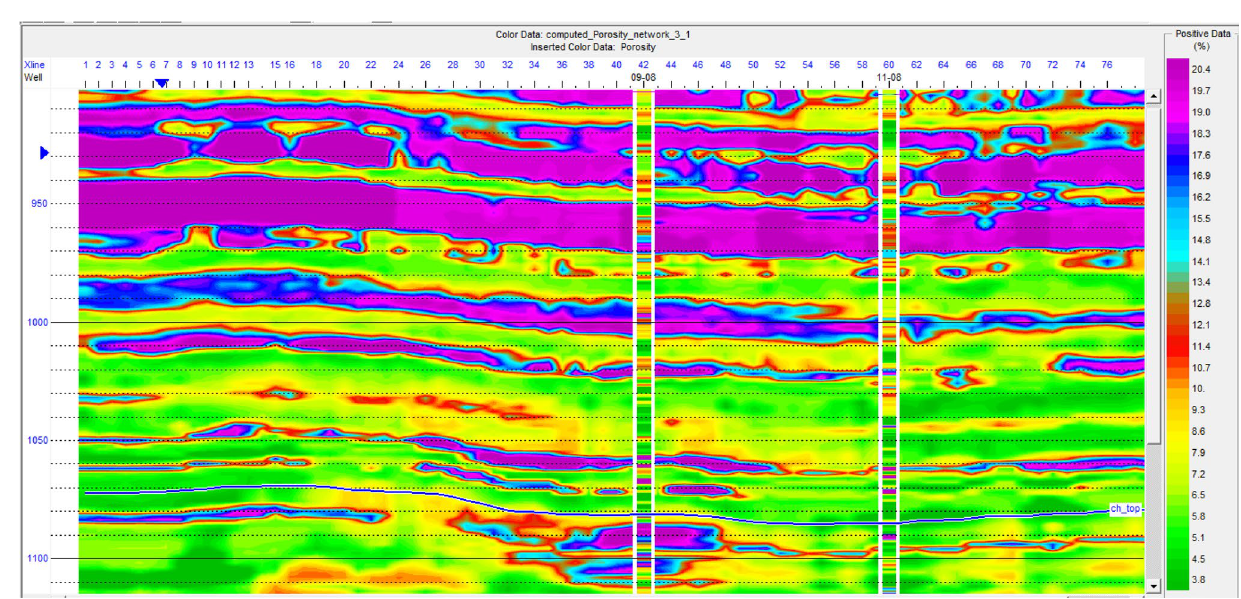
Fig. 22 Porosity obtained from the PNN network applied to the third category data at one section and the desired well parameter Fig. 23 Diagram porosity estimates versus actual porosity for the third category using the network